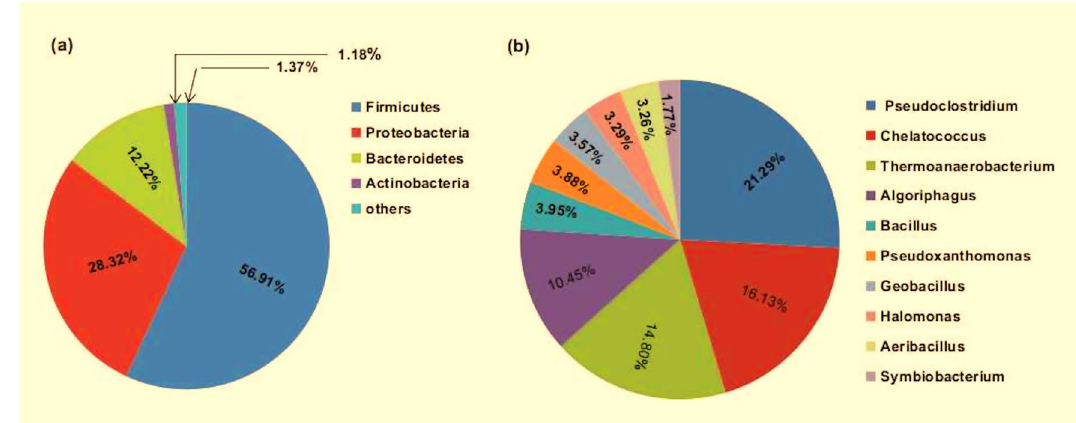
Figure 5. Taxonomic origin of bacteria in RSV consortium ( a ) Phylum and ( b ) Genus